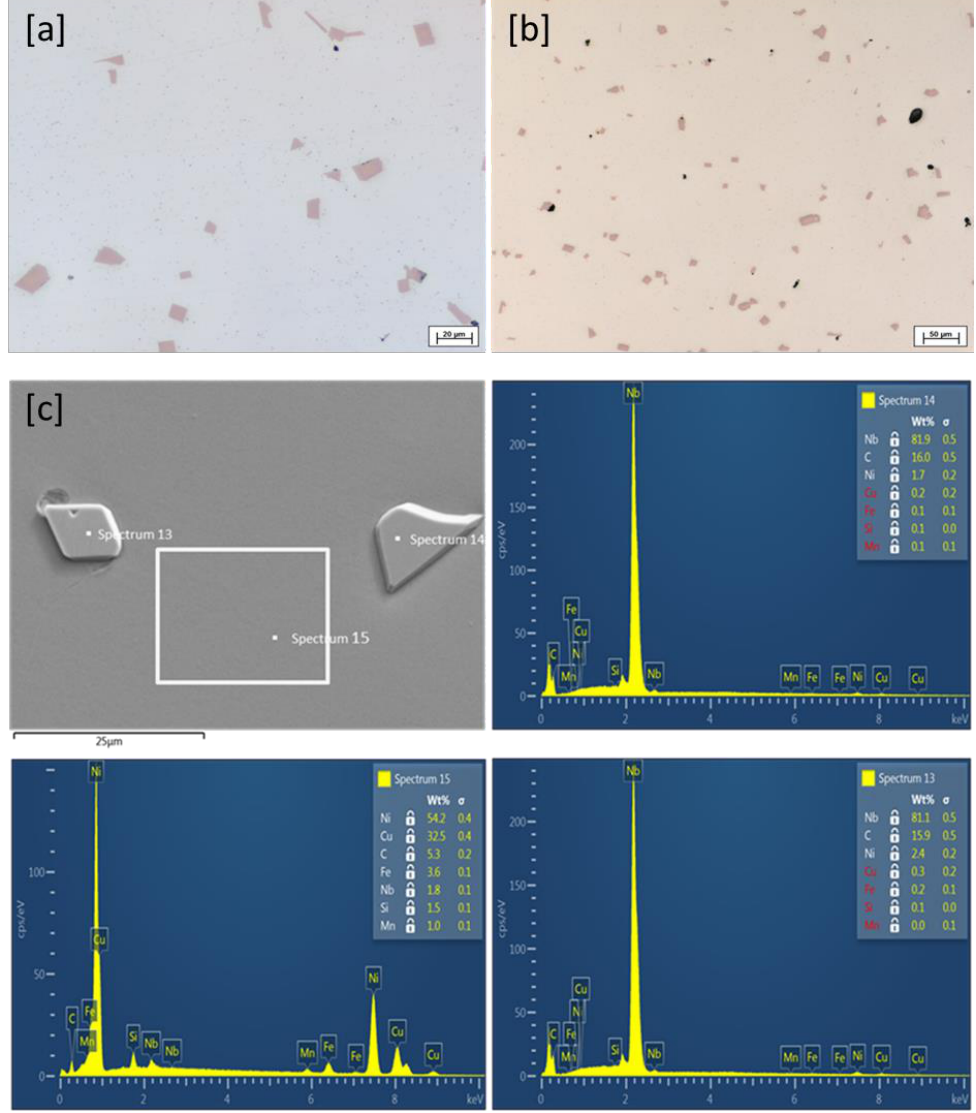
Figure 6. LOM: ( a ), ( b ) LOM of unetched as-cast samples showing randomly dispersed NbC particles; SEM/energy-dispersive spectroscopy (EDS): ( c ) EDS quantitative measurements of NbC particles in as-cast sample.